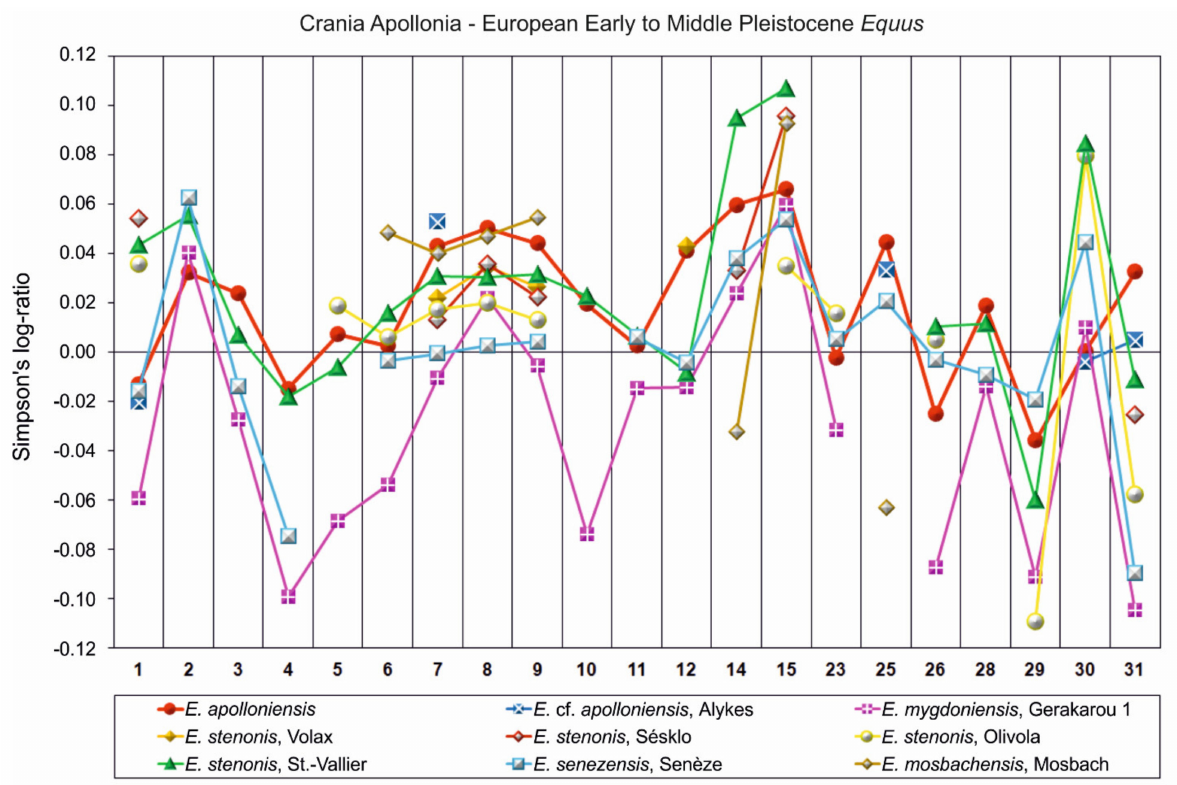
Figure 8. Simpson’s log-ratio diagrams comparing the cranial dimensions of E. apolloniensis with other equids from Greece and Europe. Standard: Equus grevyi [69]. Data from [62,76] and personal dataset. For definitions of meas., see Supplementary